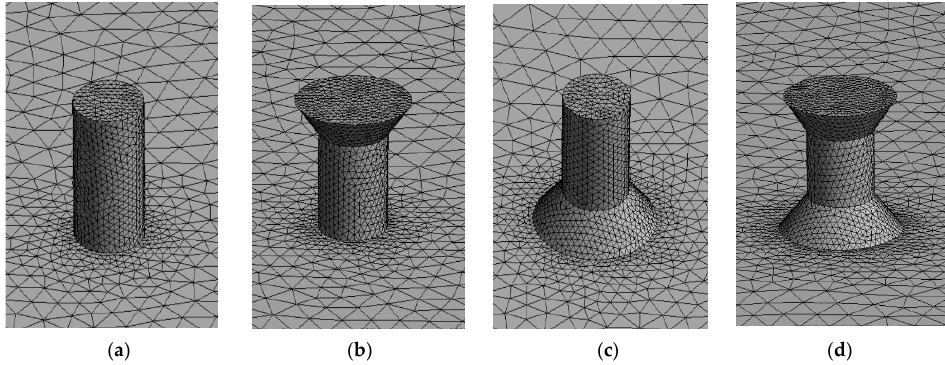
Figure 9. Mesh division of different suction hole shapes. ( a ) Cylindrical-shaped suction hole; ( b ) Funnel-shaped suction hole; ( c ) Horn-shaped suction hole; ( d ) Diabolo-shaped suction hole.